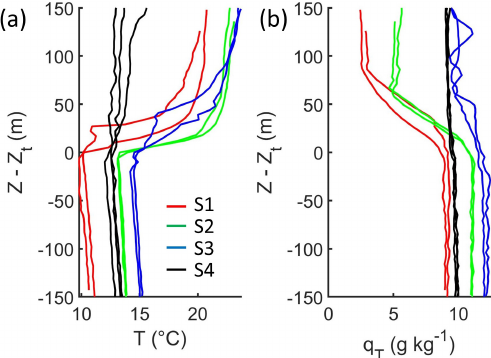
Figure 7. Vertical profiles of (a) T and (b) q T as a function of dis- tance from cloud top. Each line corresponds to an individual ascent through cloud during a sawtooth. The profiles flown during S2 and S3 (S1 and S4) had contact (separation) between the above-cloud biomass burning aerosol layer and cloud